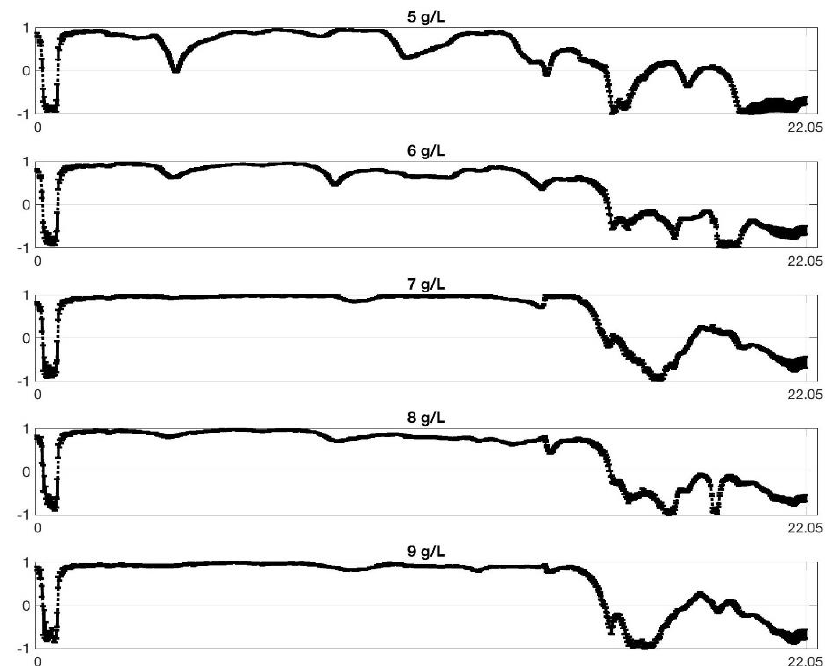
Figure 4. Spectral information of the vibrational absorption bands of ten different concentrations of fructose in distilled water (from 0 g/L to 9 g/L). The curves represent average and normalized values of sound pressure level (dB/Hz) over the audible frequencies range (20 Hz–22.05 kHz) for the samples from Table 1.